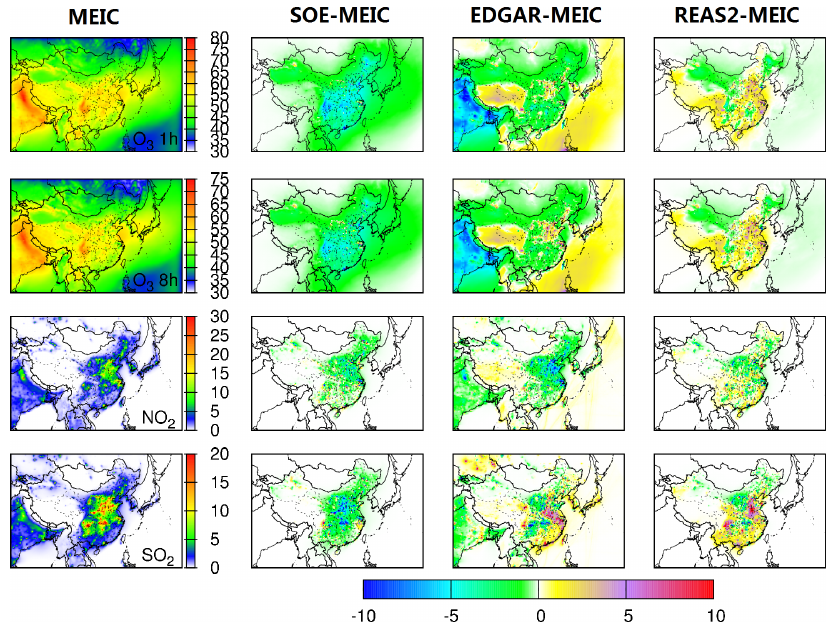
Figure 4. Spatial differences of model-predicted annual average gas species concentrations (in the horizontal panels) with different invento- ries (in the vertical panels). Units are ppb. The color bars of the first column are different to better show the spatial distribution of different species. White indicates zero, while blue, green, yellow, and red mean concentrations from low to high. The color bars for the other three columns are same; white indicates zero and blue and green mean values less than zero, while yellow, purple, and red mean values larger than zero. O 3 -1h represents daily maximum 1h O 3 and O 3 -8h represents daily maximum 8h mean O 3 .